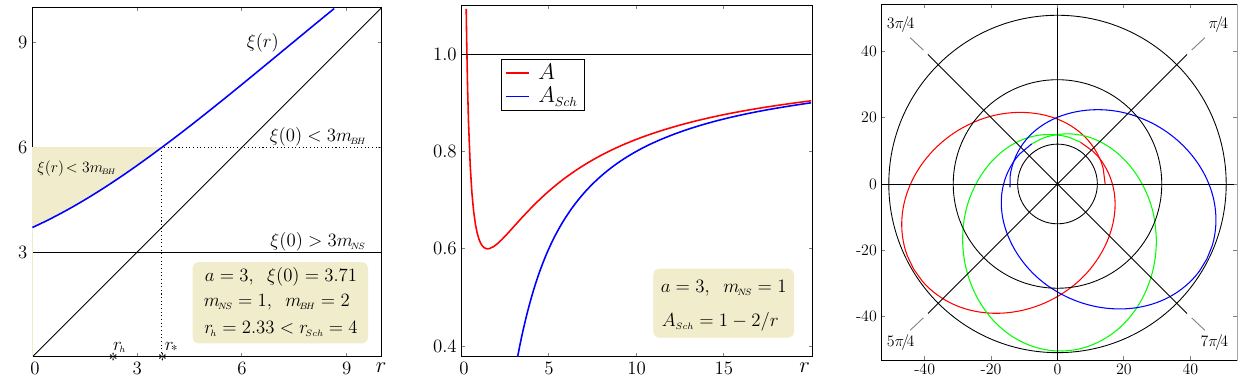
m = 1. For this Schwarzschild spacetime, the shape of the orbit with the parameters J = 5 . 12, E = 0 . 97, r min = 14 . 35, r max = 50 . 33, and Δϕ = + 1 . 05 ≈ π/ 3 is plotted in the right